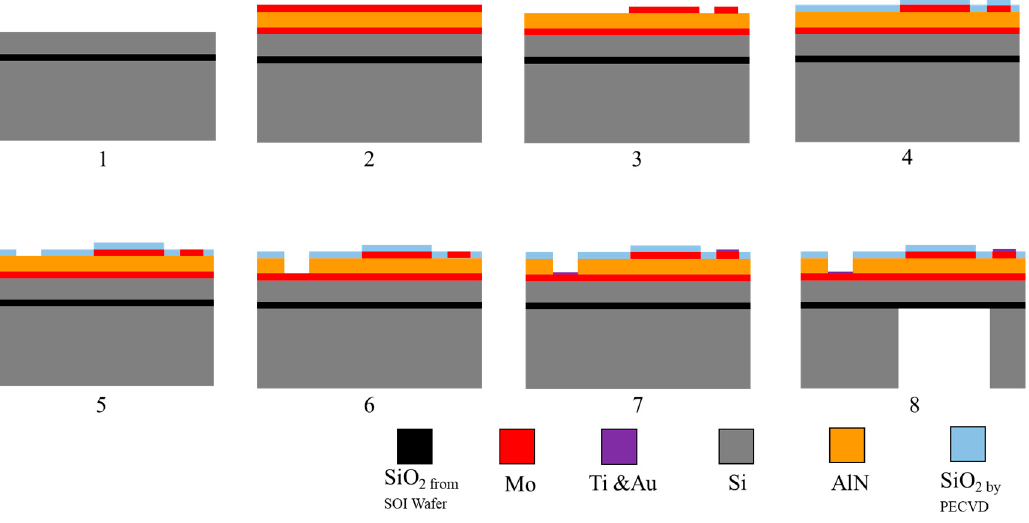
Figure 7. PMUT micromachining process